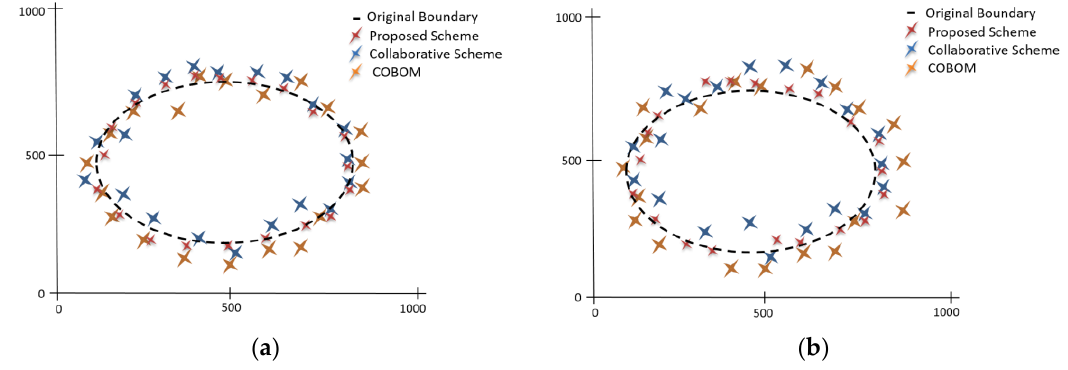
Figure 12. Phenomenon shape estimation considering a ( a ) single failed node and ( b ) two failed nodes.